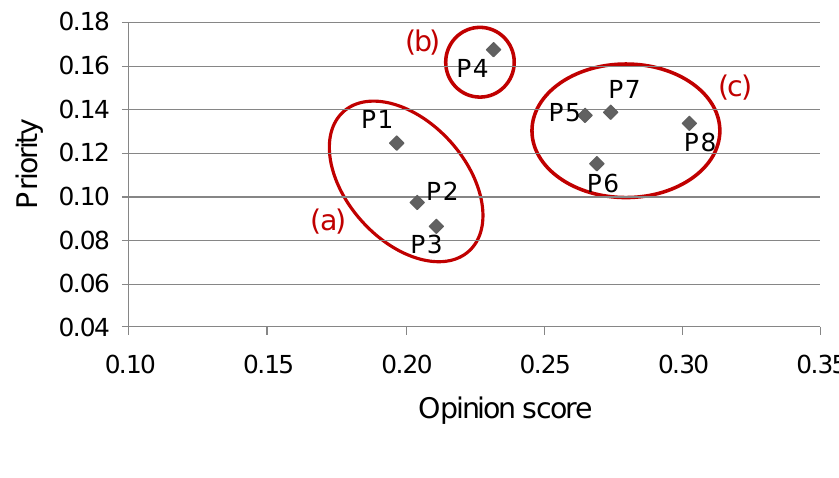
Figure 1. Distribution of the